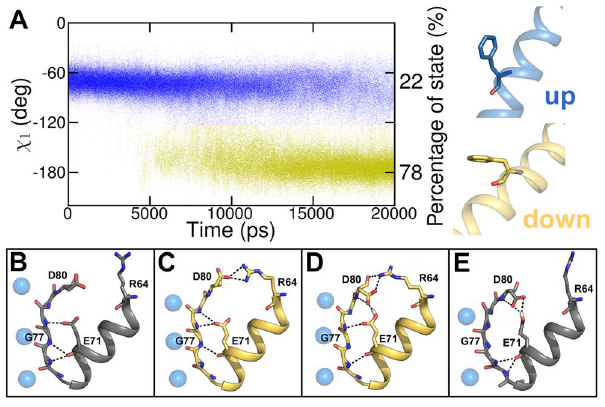
Figure 3. Conformational changes of F103 during activation gate opening and SF conformations of channel states. A) Analysis of x 1 angle dynamics of F103 (in ten opening ED simulations). Changes of the F103 orientation ( x 1 angle) were measured over time. An angle of 2 70 u indicates the ‘‘up’’ state (blue) while an angle of 2 180 u represents the ‘‘down’’ state (yellow). The percentage of state was calculated from the end states at 20 ns of the ten ED simulations. B) SF and P-helix of the closed crystal structure (gray). Blue spheres represent K + ions. C) SF and P-helix at the end of the 20 ns ED simulation structure with deprotonated E71 (yellow). D) SF and P-helix at the end of the 20 ns ED simulation structure with protonated E71 (yellow). E) SF and P-helix of the open inactivated crystal structure (gray). The G77 conformation defines the SF state as it was shown by Cuello et al. [12].